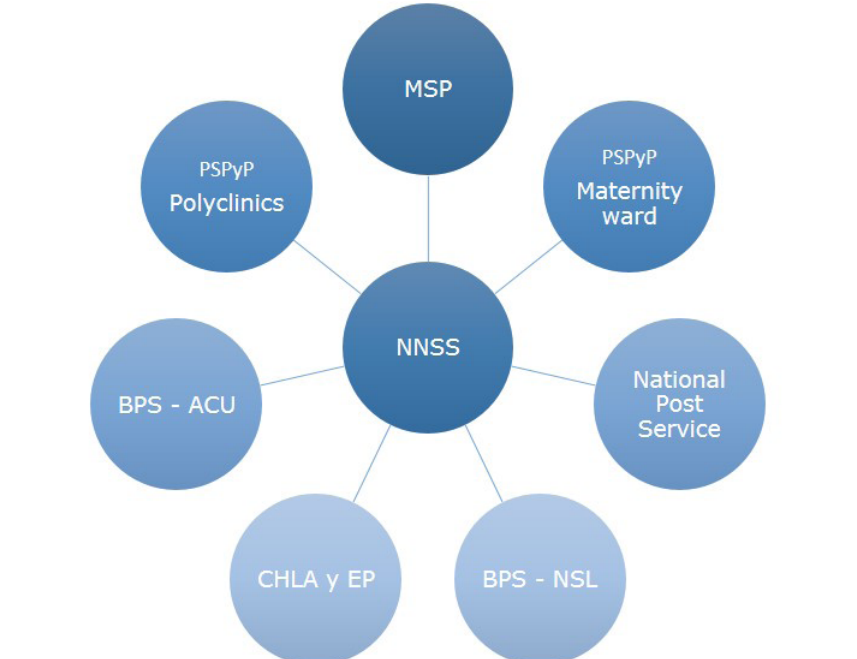
Figure 2. Scheme of National Public and Private Organizations that work together for the proper functioning of the NNSS. MSP: Ministerio de Salud Pública. PSPyP: Public and Private Health Providers. BPS: Banco de Previsión Social. NSL: Newborn Screening Laboratory. CHLA and EP: Comisión Honoraria para la Lucha Antituberculosa y Enfermedades Prevalentes. ACU: Ambulatory Care